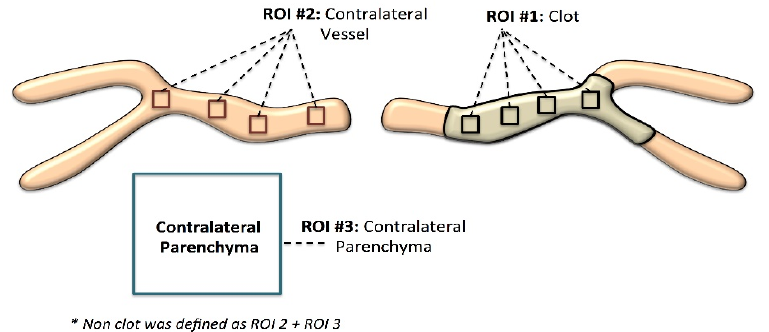
Figure 1. Regions of interest (ROIs) selected from three separate regions in the baseline NCCT: (1) thrombus: four 3 × 3 voxel ROIs were placed within the thrombus with the boundaries being determined using corresponding registered CTA datasets. (2) Contralateral artery: four 3 × 3 voxel ROIs were placed within the contralateral artery; the lumen of the artery was identified on the registered CTA and four 3 × 3 ROIs were placed along the center axis of the lumen. Hounsfield units were measured in the NCCT. (3) Contralateral parenchyma: a 10 × 10 voxel ROI was placed in the contralateral parenchyma in the NCCT.